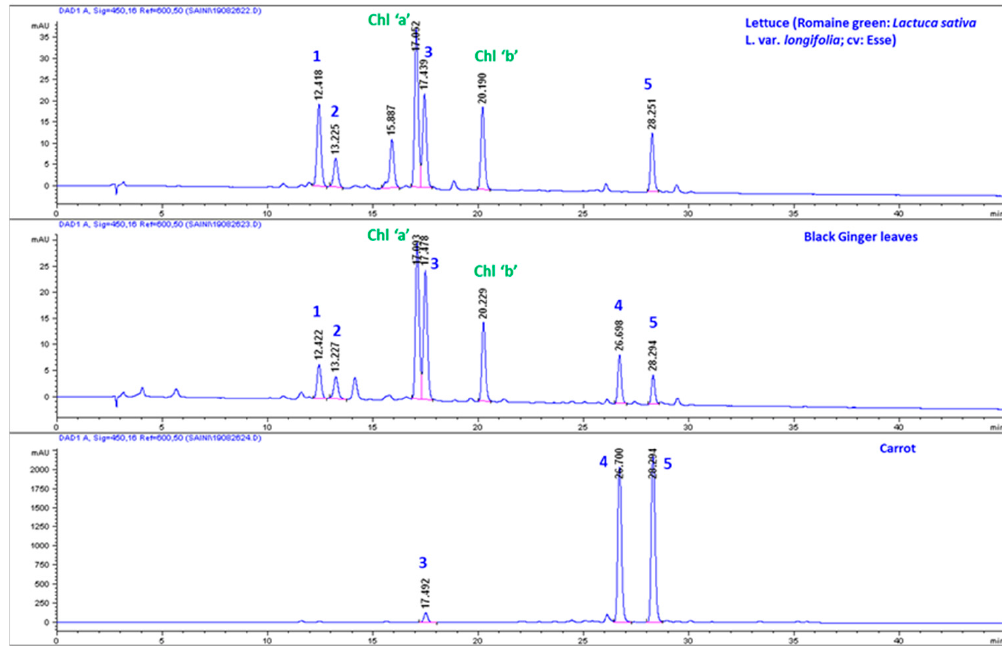
Figure 5. HPLC analysis of pigments in black ginger, carrot, and lettuce. (1) (all-E)-Violaxanthin; (2) (all-Z)-Neoxanthin; (3) (all-E)-Lutein; (4) (all-E)- α -carotene; (5) (all-E)- β -carotene; Chl: chlorophyll. To the best of our knowledge, there are no reports on the fatty acid profile of KP-BG. In this study, the fatty acid composition of KP-BG leaves was examined using GC–FID/MS for the first time. α -Linolenic acid was found (39.68–43.12%) to be the most abundant fatty acid in KP-BG leaves (Table 2). Similarly, α -Linolenic acid was identified as the predomi- nant fatty acid in the leaves of Mertensia maritima [39], Aronia melanocarpa [45], Sedum da- syphyllum [46], and Ajuga multiflora [60]. In the in-vitro-raised KP-BG leaves, the propor- tion of oleic acid (OA) decreased, and that of linoleic acid (LA) increased. A reverse trend